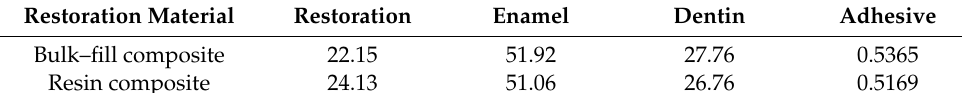
Table 4. Stress distributions in tooth components restored as a result of occlusal forces.